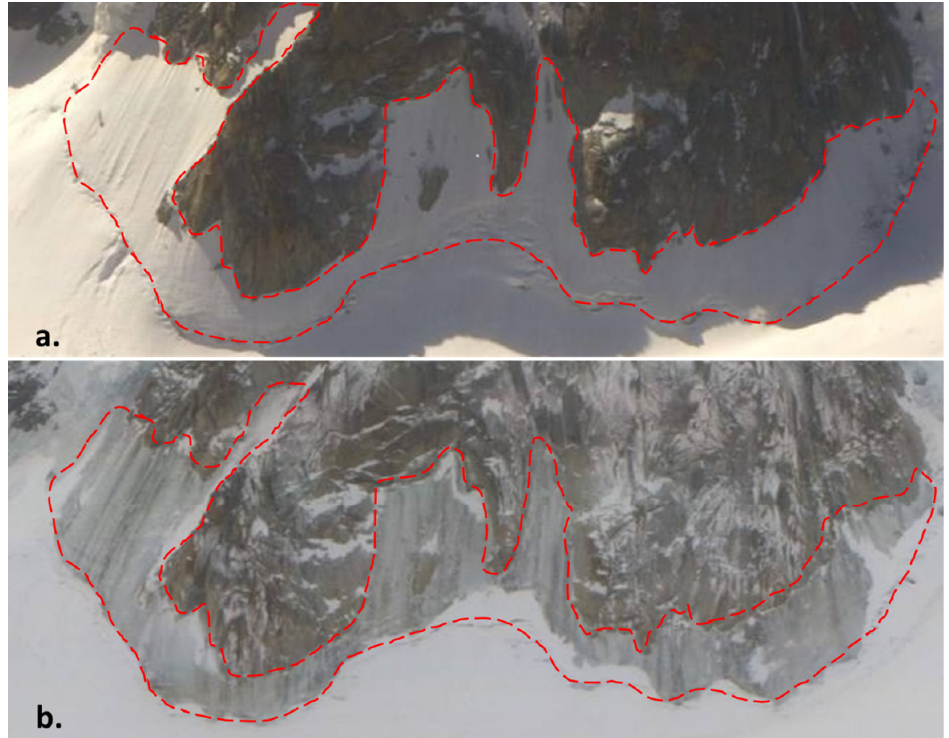
Figure 3. Evolution of an IA at the base of the Triangle du Tacul (3970 m a.s.l.; images are courtesy of Compagnie du Mont Blanc pano camera). ( a ) The red line is the limit of the IA at the end of August 2020 (the true extent of the IA), and ( b ) the image taken at the end of January 2021. The seasonal snowpack (white) can result in overestimating the IA area.